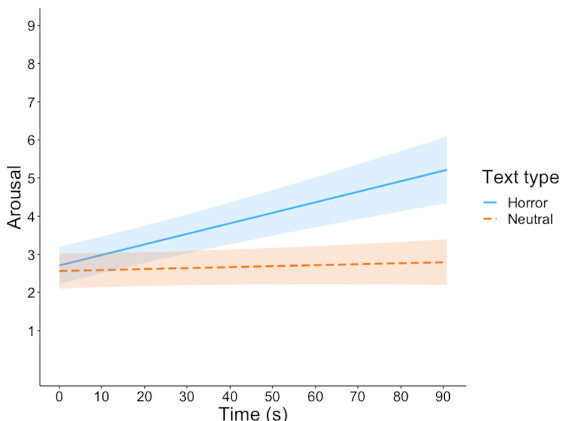
Figure 1. Model estimates for self-reported arousal. The scale on the y-axis is presented in discrete values corresponding to the SAM scale images (1 = calm, 9 = extremely agitated) for the sake of clarity. Shaded areas represent 95% confidence intervals.